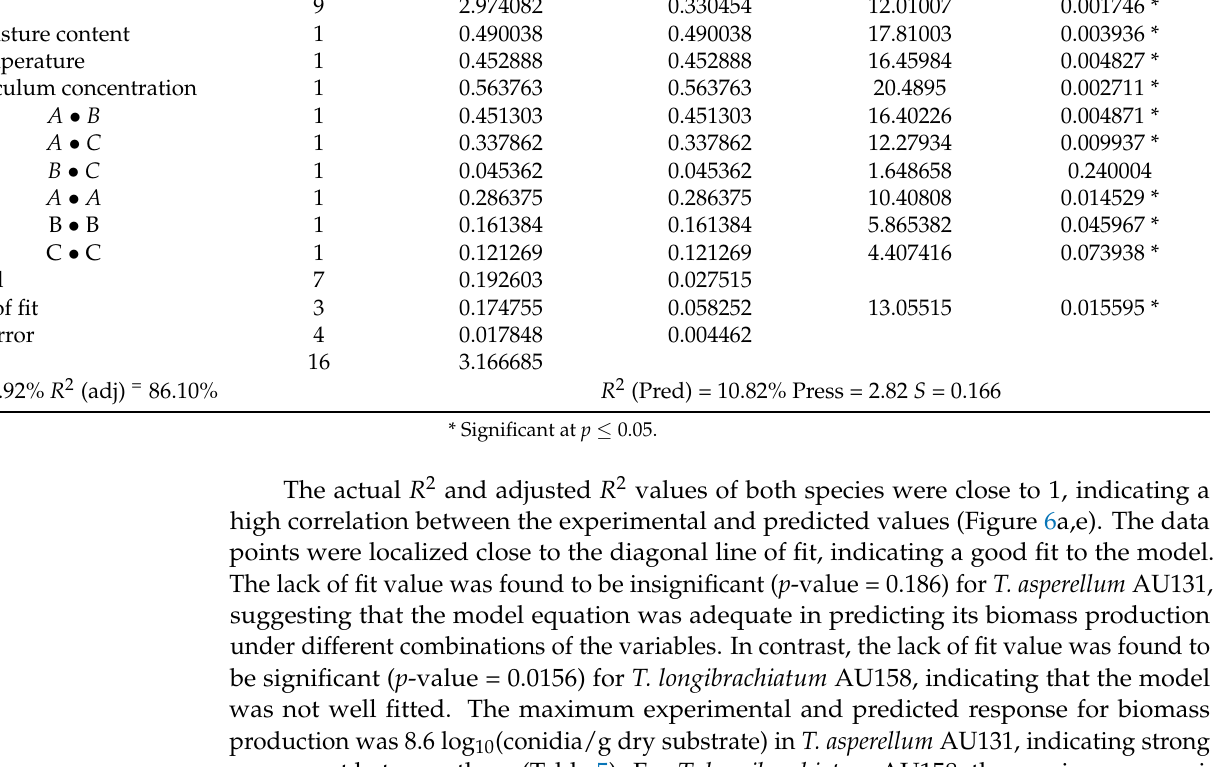
Table 10. ANOVA analysis of the experimental results for the quadratic model of T. longibrachiatum AU158. Source of